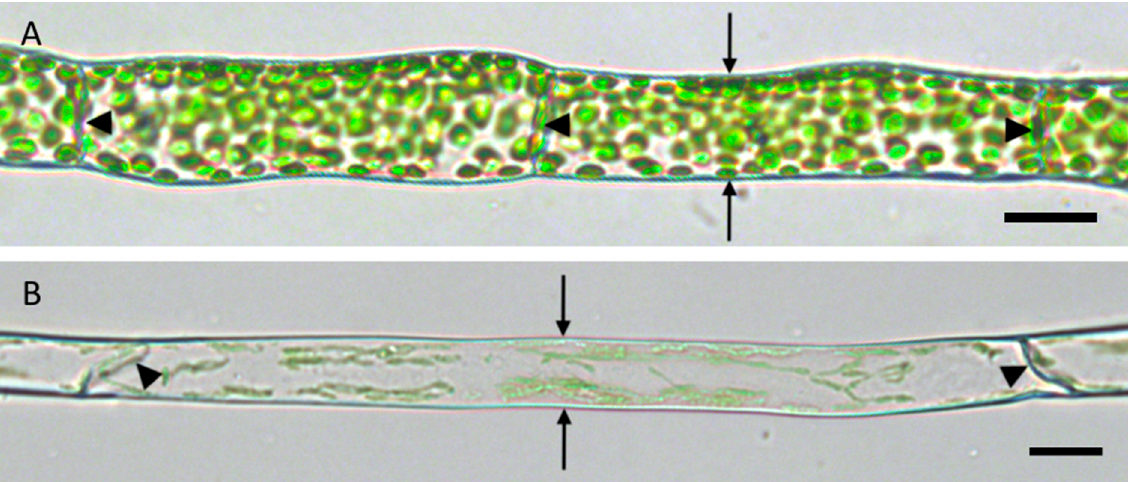
Figure 1. Typical shapes of P. patens protonema cells. ( A ) Chloronema cells with orthogonal cell wall (arrowheads) and ( B ) caulonema cells with oblique cell walls (arrowheads). The arrows point to lateral walls and show the respective diameter of the cell types. Scale bars = 20 µm.